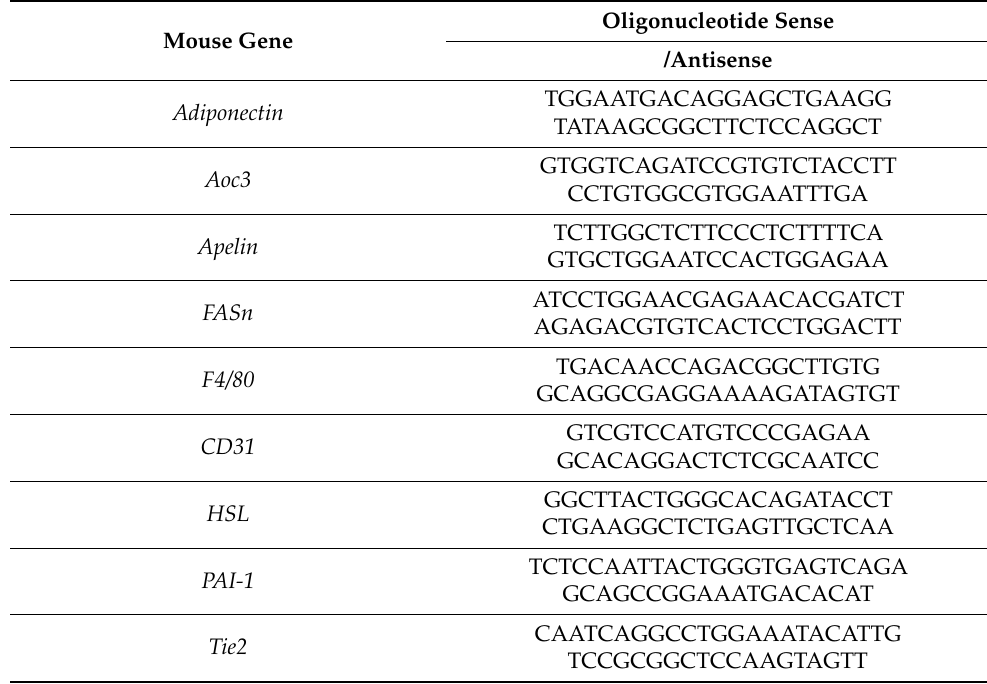
Table 1. Primer sequences for the studied mouse